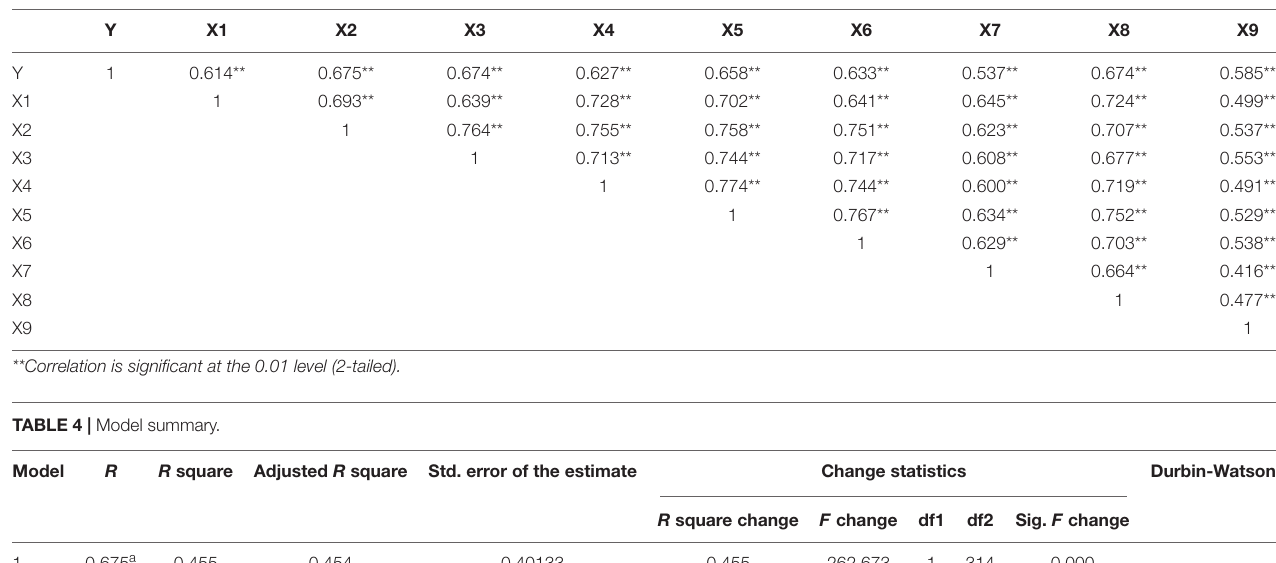
TABLE 3 | Pearson’s correlation.